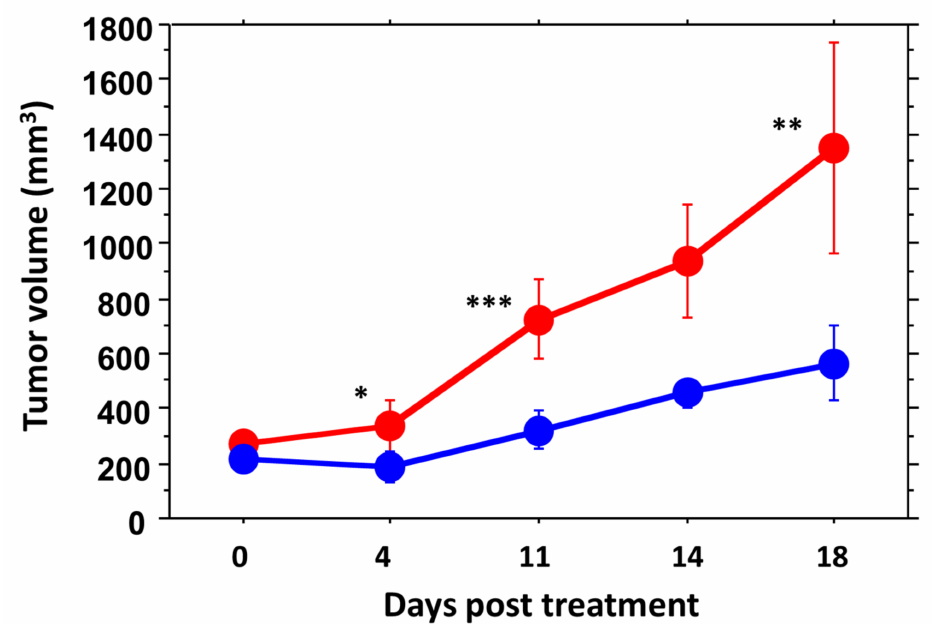
Figure 6. Growth curves for groups of orthotopic MDA-MB-231-luc tumors comparing saline controls (red, n = 6) and OXi6197 (20 mg/kg twice weekly, blue n = 5). At baseline the two groups had similar mean volumes, but within 4 days of treatment mean tumor volume was significantly different: 4 days (* p < 0.05), day 11 (*** p < 0.001) and day 18 (** p < 0.01). Curves for individual tumors are presented in Supplementary Figure